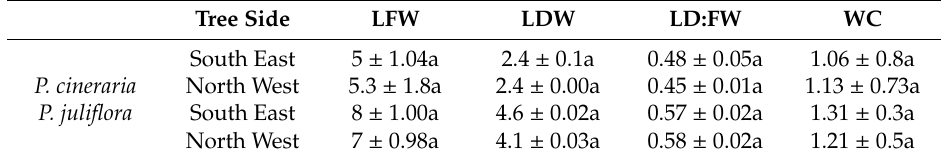
Table 3. E ff ect of canopy position of Prosopis juliflora and Prosopis cineraria on the plant biomass traits (leaf fresh weight (g) LFW; leaf dry weight (g) LDW; leaf dry / fresh weight ratio, LD:FW; and water contents (WC). Tree Side LFW LDW LD:FW WC